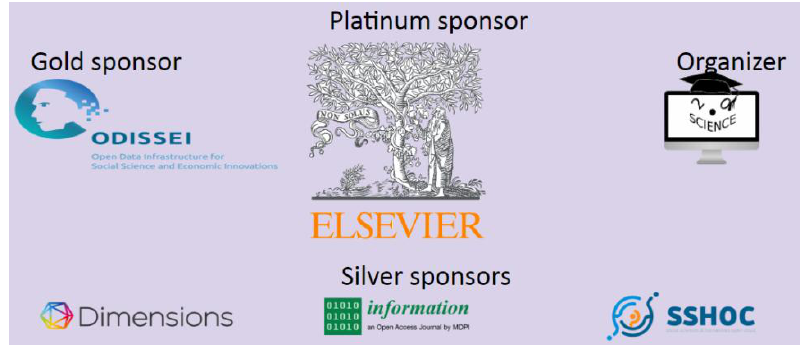
Figure 2. The ICTeSSH 2020 Conference